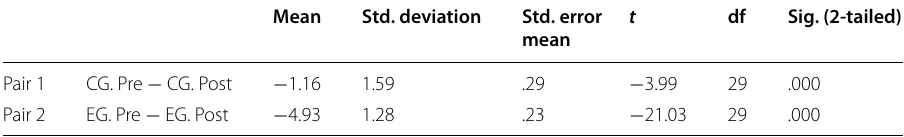
Mean Std. deviation Std. error